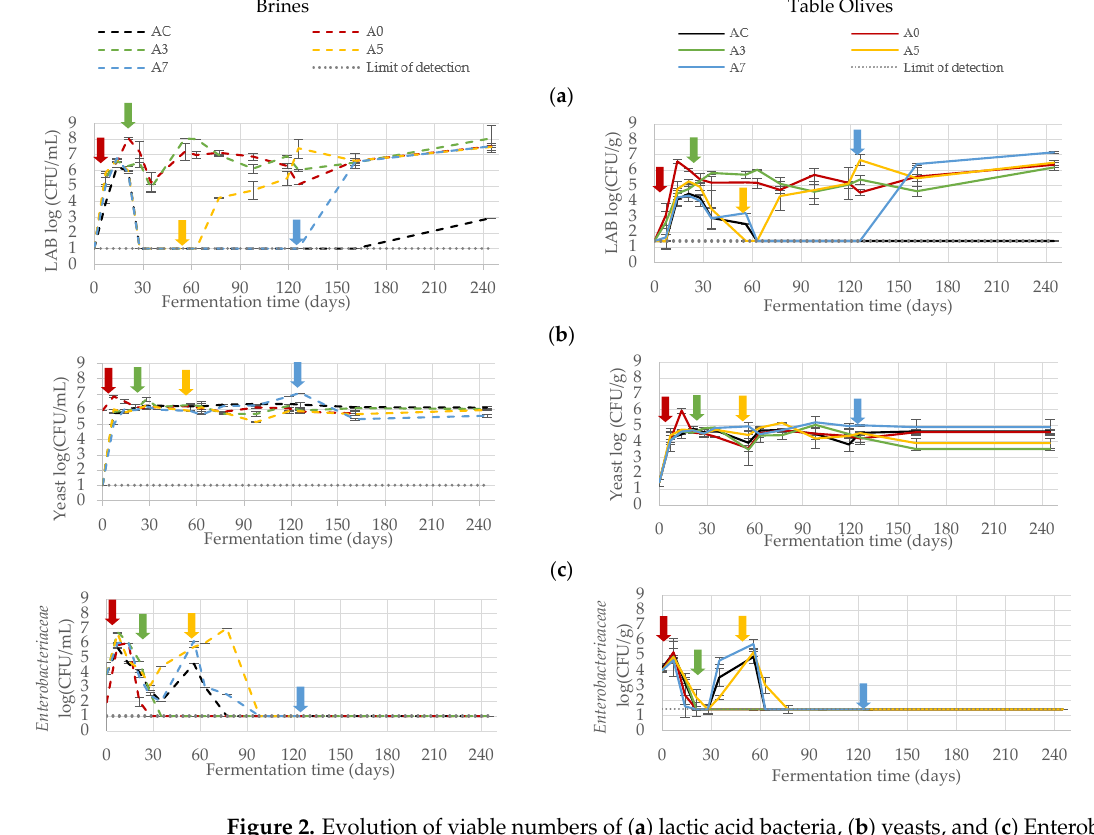
Figure 2. Evolution of viable numbers of ( a ) lactic acid bacteria, ( b ) yeasts, and ( c ) Enterobacteriaceae, in ( left ) brines and ( right ) table olives, under plan A. Arrows indicate the moment of inoculation with Lpb. pentosus i106 and the corresponding salt addition to all vessels.